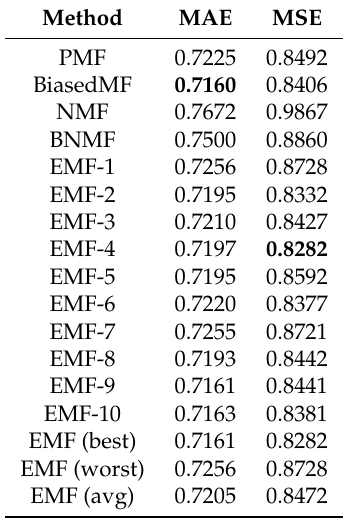
Table 3. Mean Absolute Error (MAE) and Mean Squared Error (MSE) in predictions for MovieLens